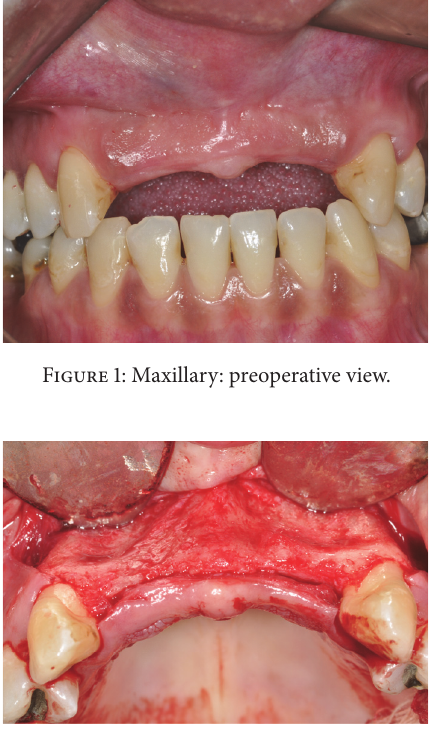
Figure 2: The total-thick flap raised.